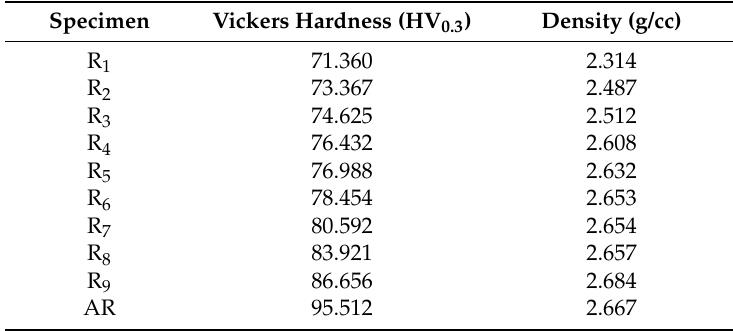
Table 4. Evolution of hardness and density with respect to different processing parameter.